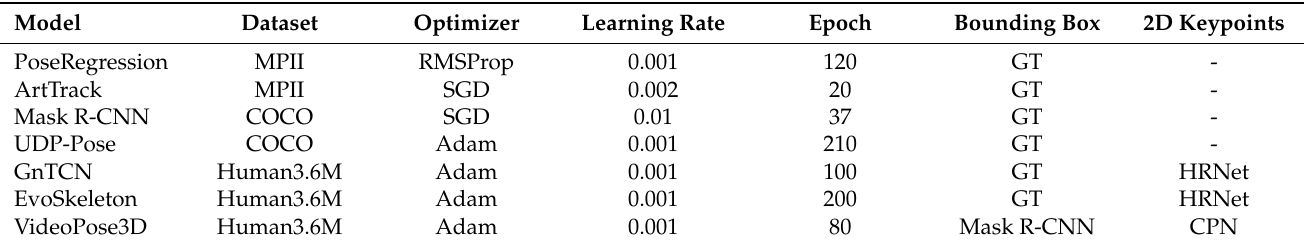
Table 3. Training details of the evaluated 2D and 3D pose estimation models. GT in the Bounding box column means that the models used ground truth bounding boxes in the training process. The column 2D keypoints show the 2D pose estimation model, which produced inputs for the training of the 3D pose estimation